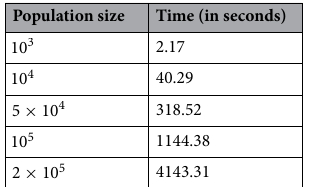
Table 4. Running time of the selected undirected model for different population